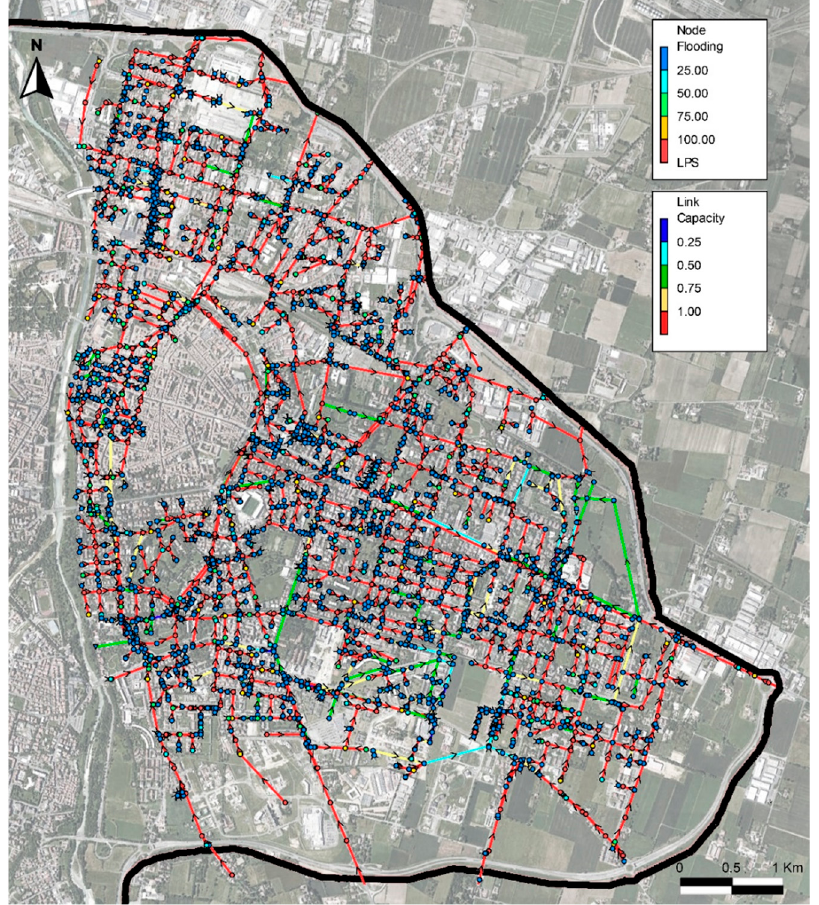
Figure 8. Criticalities of the east part of the sewerage